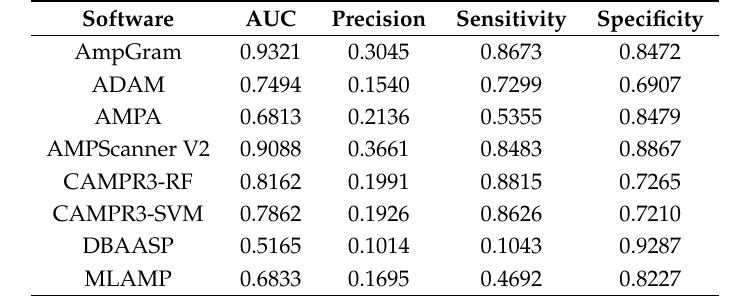
Table 5. Comparison of AmpGram and AMPscanner [24] performance on the DAMPD dataset with other predictors from Gabere and Noble’s benchmark and according to their methodology [29]. Sequences used to train either AmpGram or AMPScanner were removed from the dataset. The benchmark without their removal is presented in Table S5 in the Supplementary Materials. The